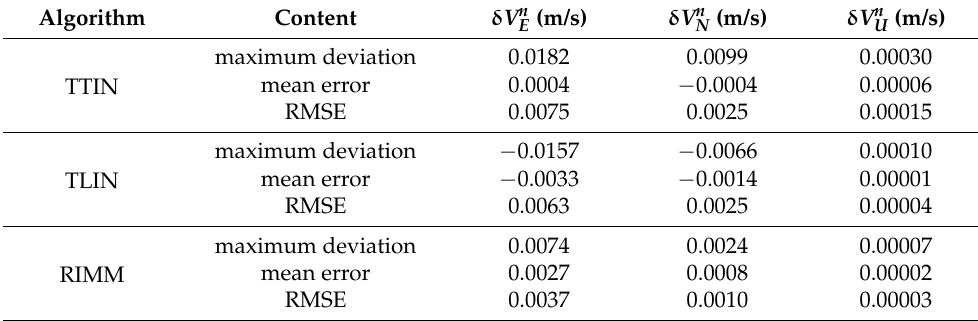
Figure 7. Velocity errors of three algorithms when DVL w orking p roperly. Table 2. Velocity error parameters for the three algorithms when DVL working properly. Table 2. Velocity error parameters for the three algorithms when DVL w orking p roperly.